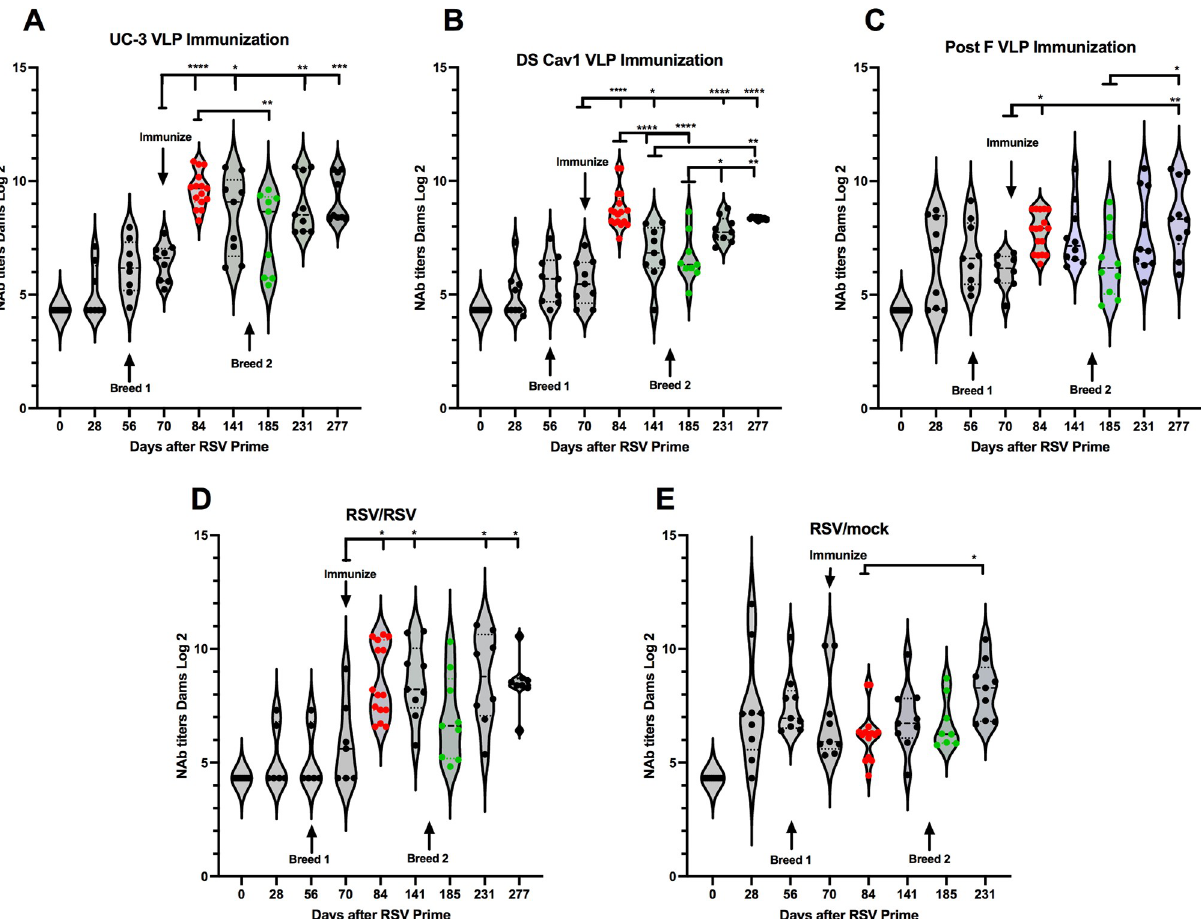
Fig 4. Neutralization titers in dams. The serum NAb titers in dams, primed with RSV at day 0 and immunized at day 70, at each time point are shown. NAb titers of sera from animals immunized with 100 μ g VLP protein are shown in panels A-C while titers in animals immunized with RSV or mock immunized are shown in panels D and E. Panels A-E are presented as violin plots with individual animal data shown. Mean and standard deviation are indicated by solid and dotted black lines, respectively. Mean of each group is shown as a black horizontal bar. Red and green dots: data from sera acquired just before delivery of breed 1 or 2, respectively. Significant differences between day 70, day 85, or day 185 and later times were determined by one way ANOVA followed by post-hoc Tukey’s multiple comparisons test � p < 0.05; �� p < 0.01; ��� p < 0.001; ���� p <